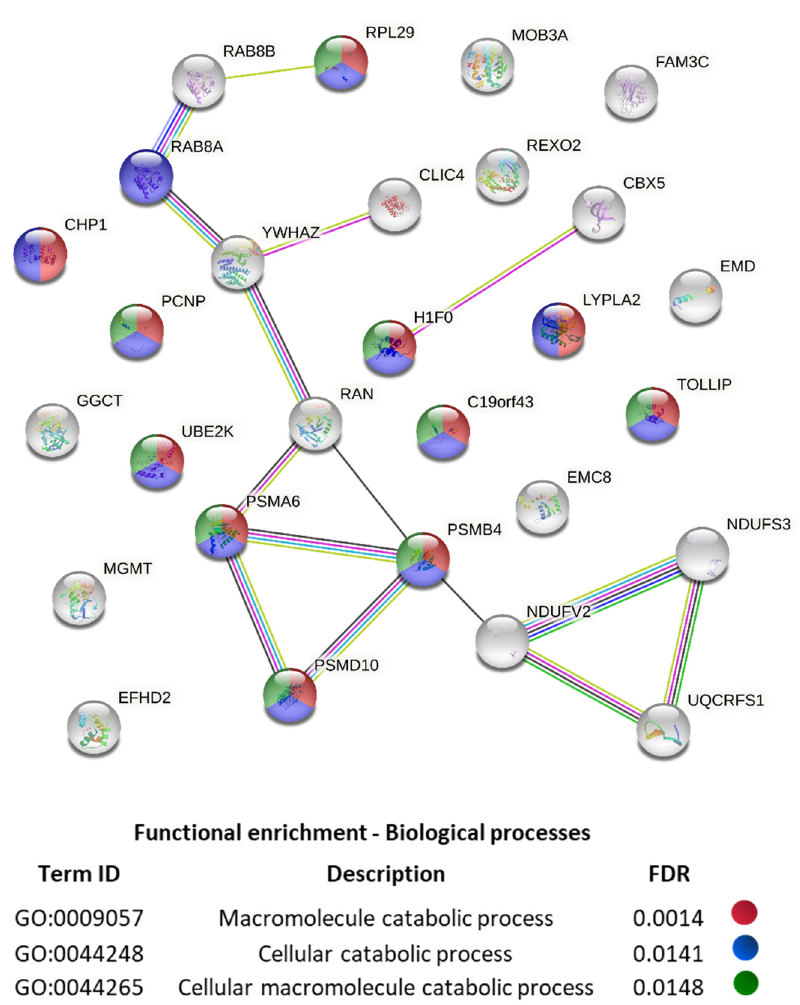
Figure 3. STRING analysis of TNF α -induced factors (default settings; edges represents protein-protein associations, nodes are filled if 3D structure is known). Protein–protein interactions and top 3 biological processes are shown. The colors in the circles represent the three biological processes.